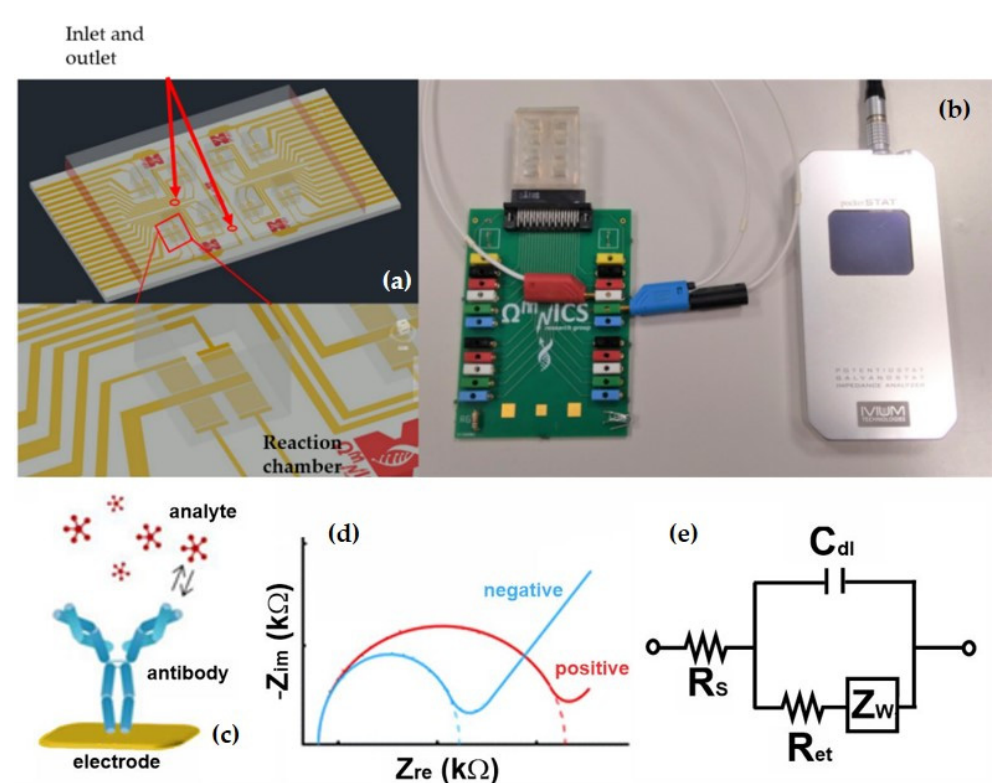
Figure 2. Schematic illustration of the LOC device optimized for the detection of GLRaV-3 and GFLV. ( a ) The device is coupled to a microfluidic module and inserted in ( b ) a PCB platform, communicating to IVIUM potentiostat for impedance analysis. Interdigited electrodes have 10 μ m lines and spacing. ( c ) Analyte detection on the functionalized electrode surface and ( d ) resulting change in Nyquist curves with positive sample (red curve) compared to negative control (blue curve). ( e ) The recorded response can be modelled using a simplified Randles equivalent circuit comprising the resistance of the electrolyte solution R s , the Warburg impedance Z w , the double layer capacitance C dl and the electron transfer resistance R et .